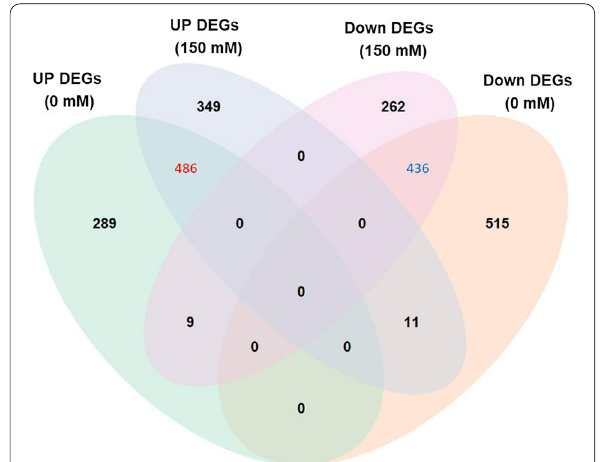
Fig. 6 Venn diagram analysis of the DEGs between Tainung 67 and OsERF106MZ ‑overexpressing rice